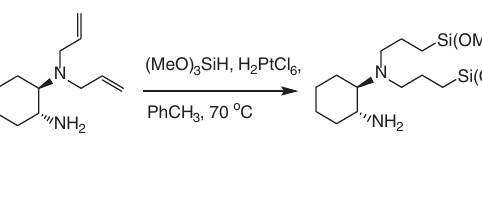
Scheme 3 Preparation of chiral amine catalyst cat-2